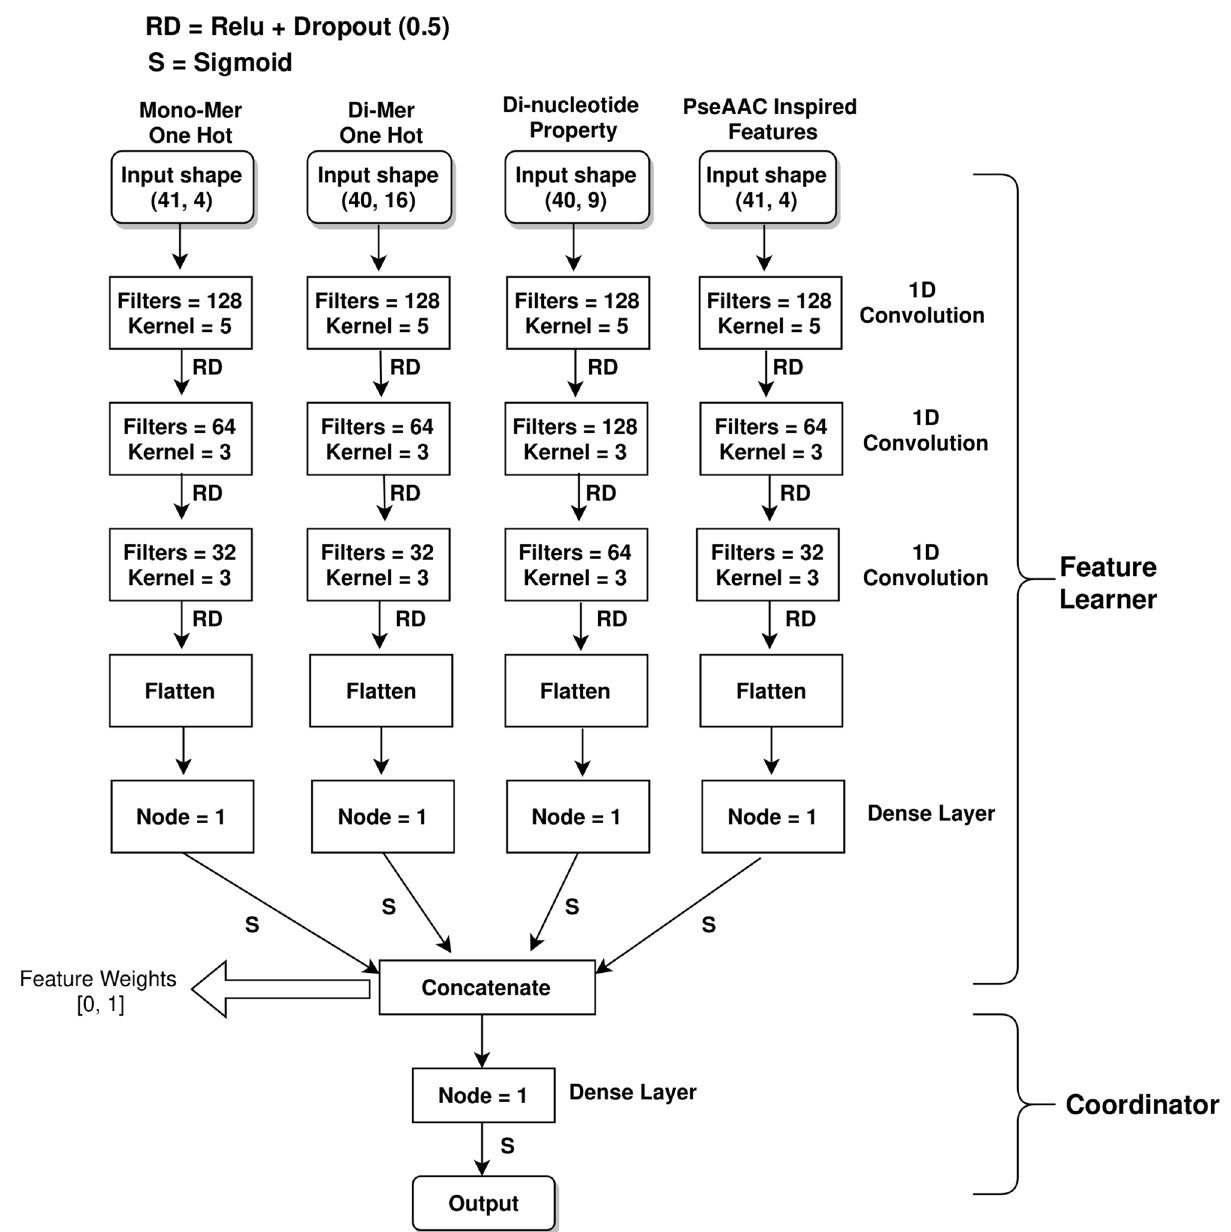
Figure 1. i6mA-CNN model